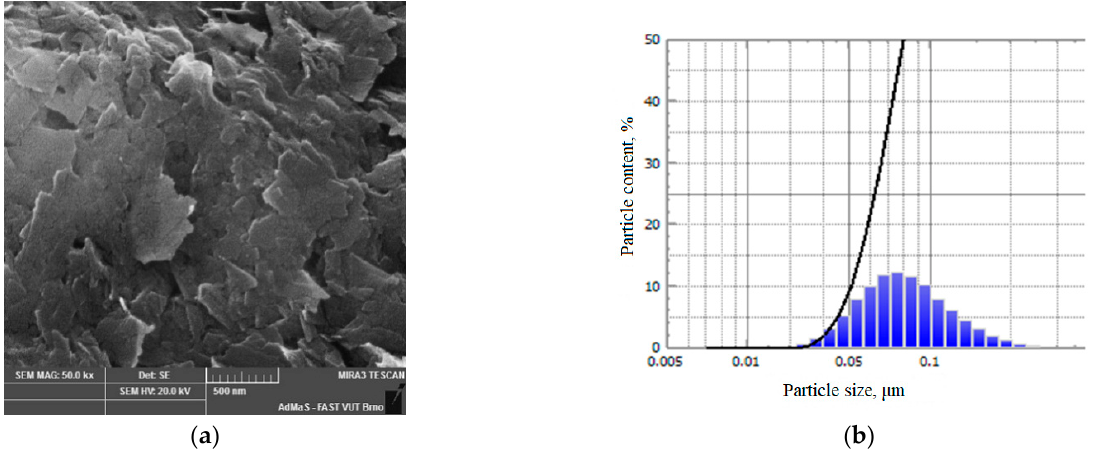
Figure 2. Carbon black particles: ( a ) microstructure at 50,000-fold magnification, ( b ) particle size distribution.